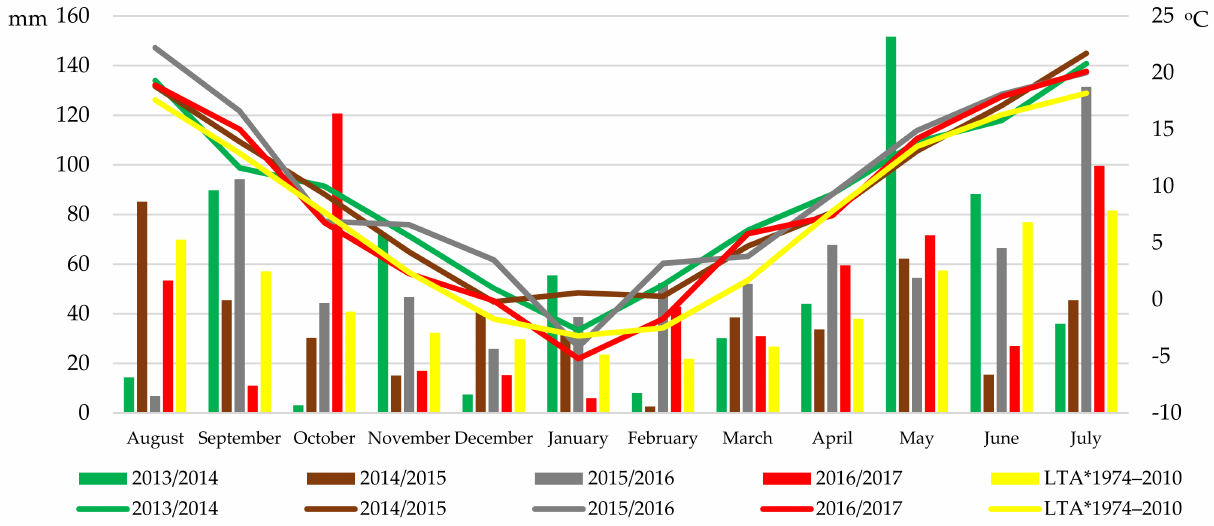
Figure 1. Total precipitations and mean monthly air temperature in the growing season of winter oilseed rape, recorded by the Meteorological Station in Bezek (Poland). * LTA—long term